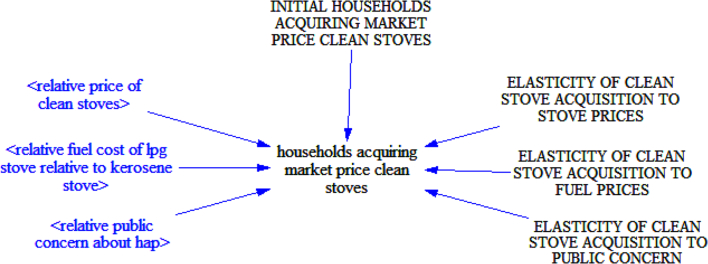
Formulation of households acquiring market price clean stoves.